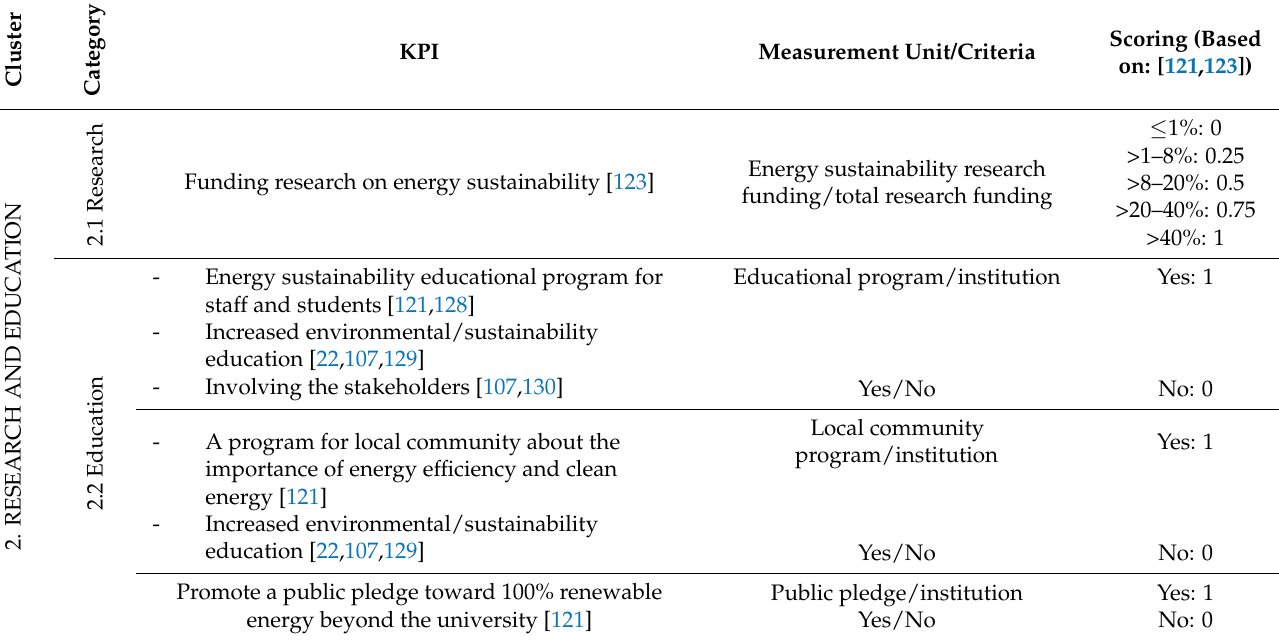
Table 2. KPIs for research and education in the field of SESs.